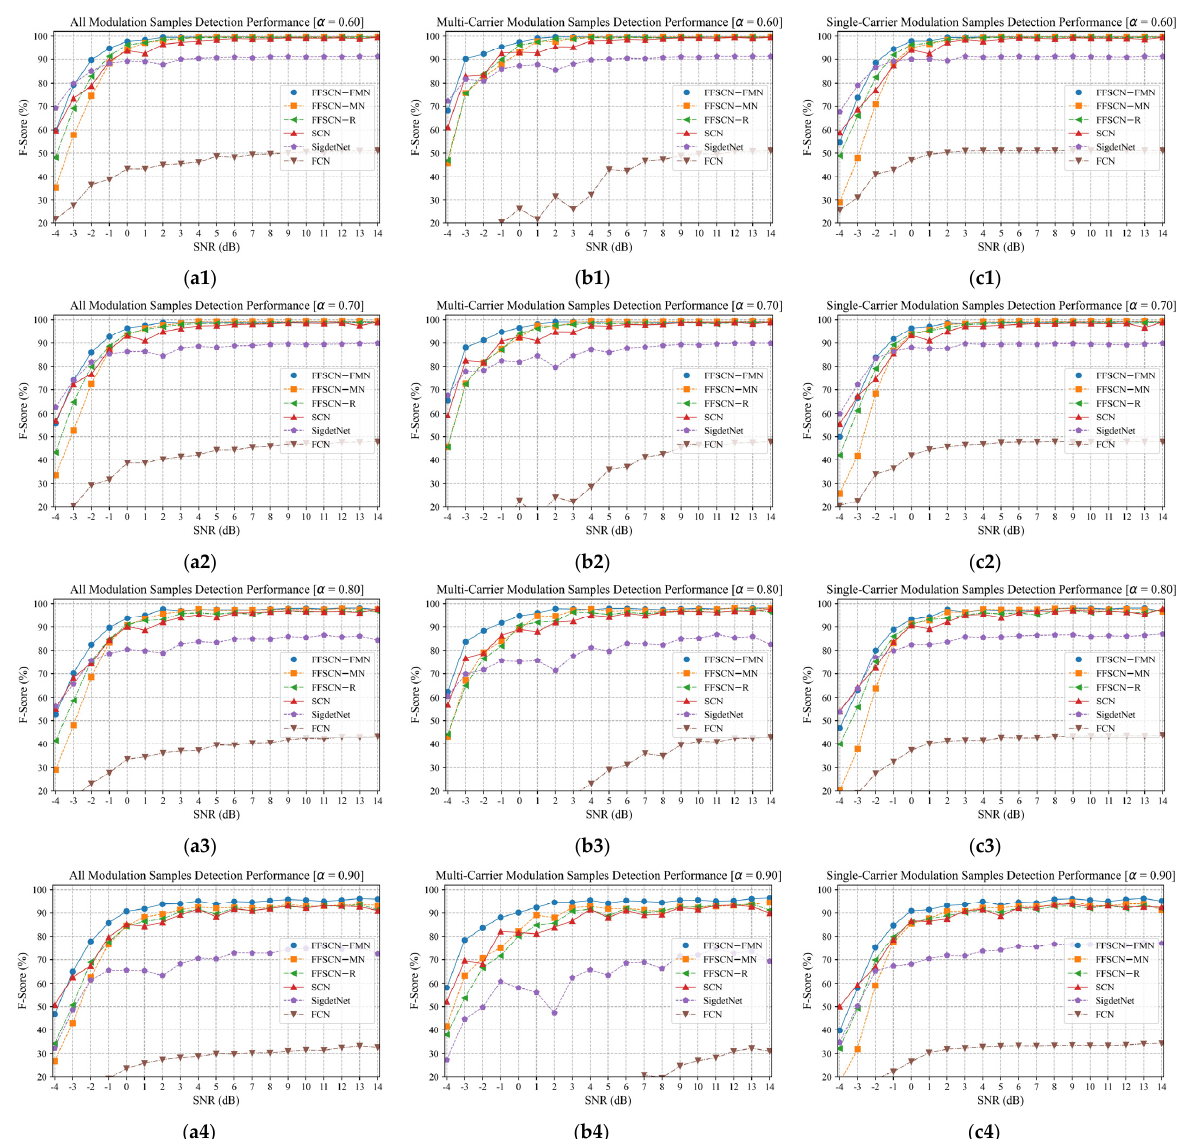
Figure 6. The multi-carrier and single-carrier modulation signal detection performances of our proposed FFSCN models and other deep-learning-based methods: ( a1–a4 ) all modulation samples’ detection performance; ( b1–b4 ) multi-carrier modulation samples’ detection performance; ( c1–c4 ) single-carrier modulation samples’ detection performance. α denotes the IoU threshold and increases from 0.6 to 0.9 from ( 1 ) to ( 4 ).